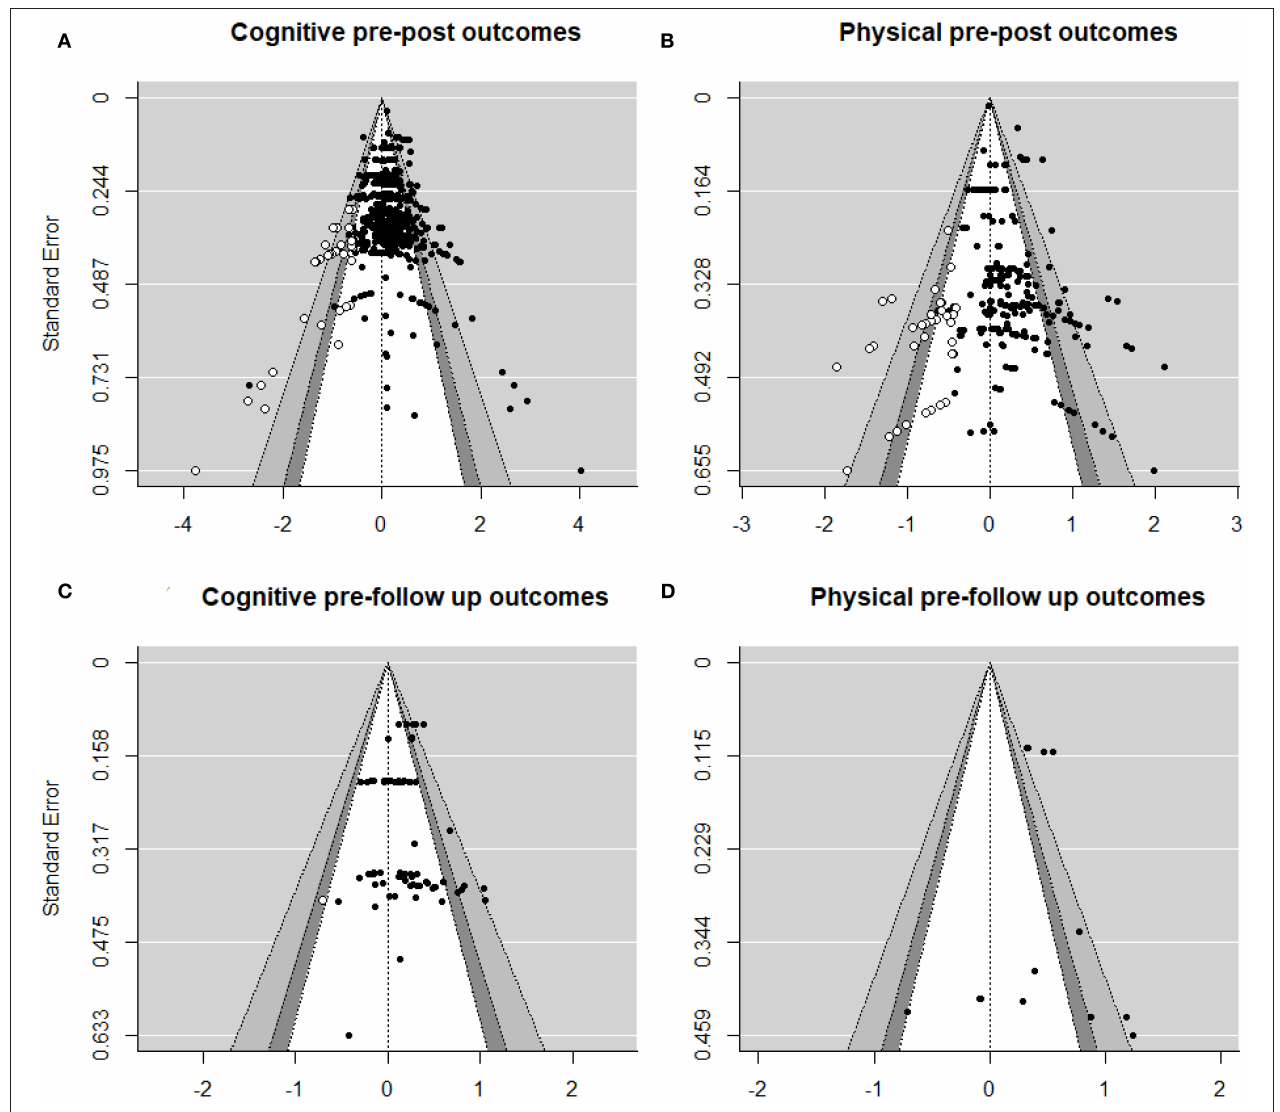
FIGURE 2 | Funnel plots with ES on the X-axis and standard error of the ES on the Y-axis for the estimated summary effects of (A) cognitive, (B) physical pre-post outcomes, (C) cognitive, and (D) physical pre-follow up